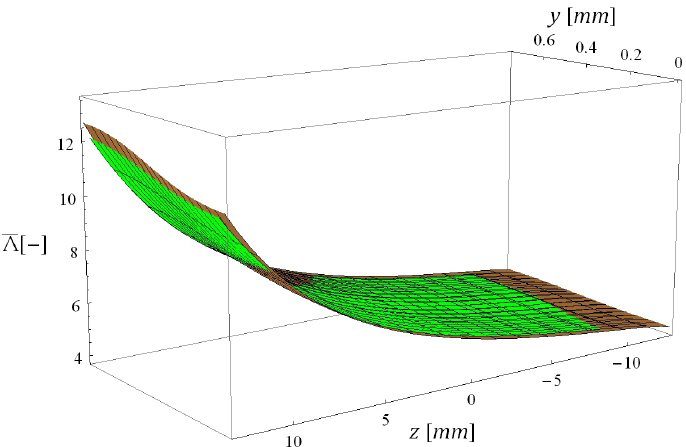
Figure 13. Mean membrane water content at 0.75 V of operational voltage. Green plot are CFD results and brown HAN-FC